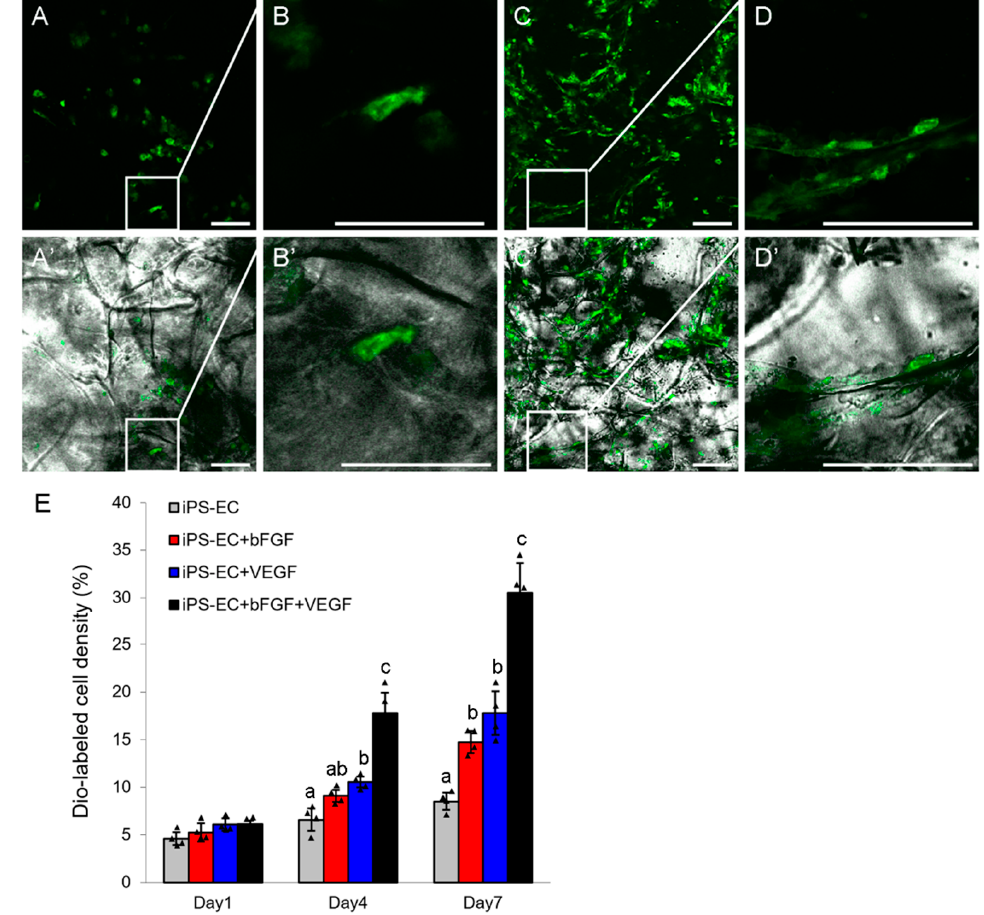
Figure 2. piPSC ‐ ECs cultured on 3D gelfoam scaffolds. ( A – D ) Confocal images of Dio ‐ labeled Figure 2. piPSC-ECs cultured on 3D gelfoam scaffolds. ( A – D ) Confocal images of Dio-labeled piPSC- piPSC ‐ ECs on gelfoam scaffolds after 1 day ( A – A ’, B – B ’) or 7 days of cultivation ( C – C ’, D – D ’). ( B – ECs on gelfoam scaffolds after 1 day ( A - A ’, B - B (cid:48) ) or 7 days of cultivation ( C - C (cid:48) , D - D (cid:48) ). ( B - B (cid:48) , D - D (cid:48) ) B ’) and ( D – D ’) are the zoomed ‐ in versions of ( A – A ’) and ( C – C ’) within the white rectangles. Scale are the zoomed-in versions of ( A - A (cid:48) , C - C (cid:48) ) within the white rectangles. Scale bar = 50 µ m. ( E ) Cell bar = 50 μ m. ( E ) Cell density assay was performed at the indicated treatments and time points. Mean density assay was performed at the indicated treatments and time points. Mean ± SD. n = 4. The ± SD. n = 4. The bars without the same letter are significantly different ( p < 0.05). bars without the same letter are significantly different ( p <